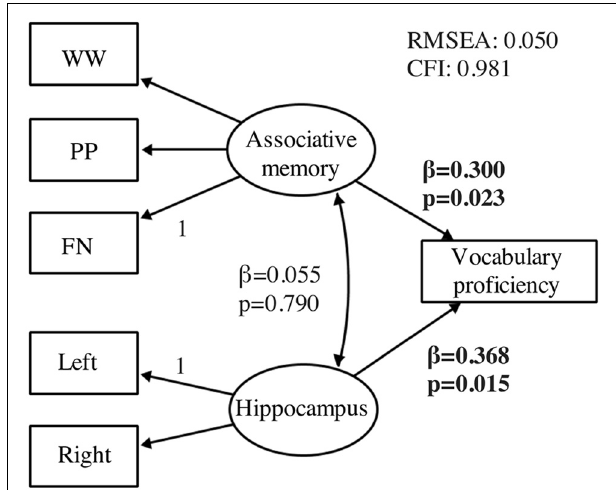
FIGURE 5 | Confirmatory structural equation model testing predictors of vocabulary proficiency. The model tests associative memory ( n = 90) and hippocampal volume ( n = 38) at pretest as predictors of vocabulary learning at the end of language training ( n = 90). All estimates are standardized and effects with p < 0.05 are presented in bold font. Regression weights are represented by single-headed arrows and covariances by double-headed arrows. Regression weights marked with a 1 were restricted to 1. All other regression weights, covariances, and intercepts were estimated. WW, word-word; PP, picture-picture; FN,